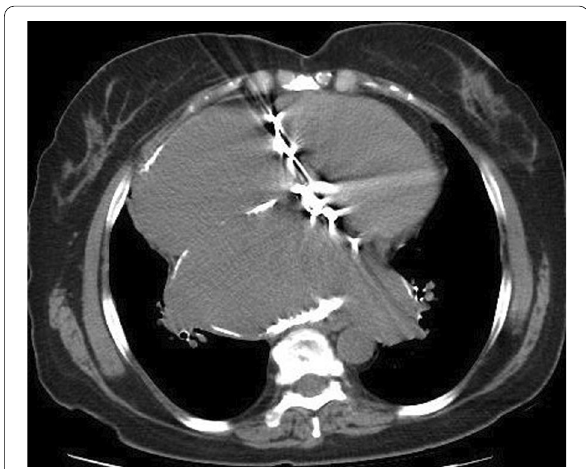
Fig. 1 Axial chest CT scan (mediastinal window) shows right and left atrial walls and interatrial septal calcification along with biatrial enlargement. Mitral and tricuspid metallic prosthetic valves are also seen